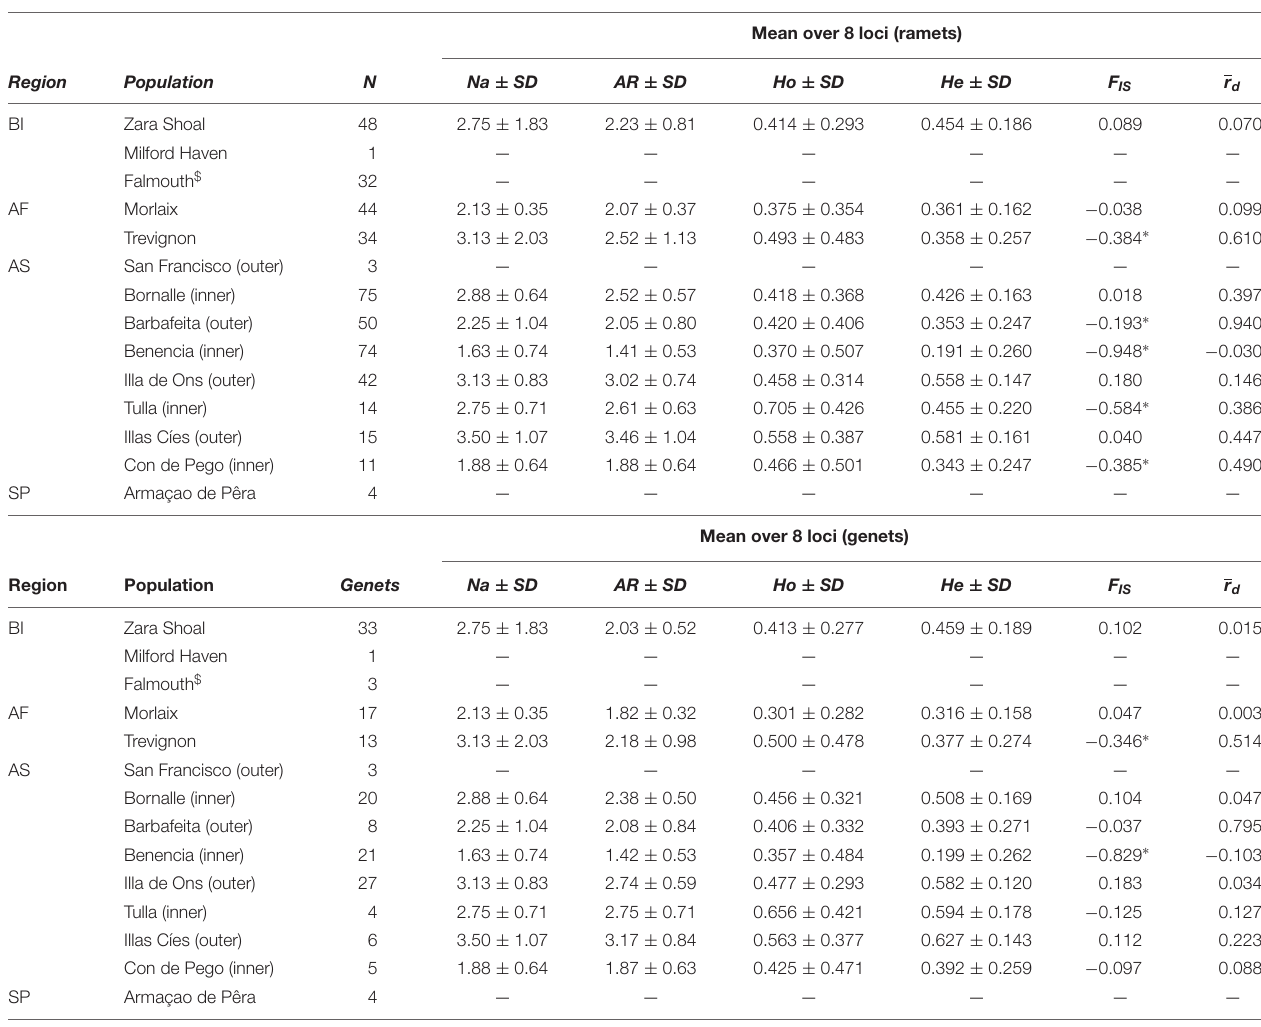
TABLE 2 | Genetic diversity estimates, inbreeding coefficient and linkage disequilibrium calculated for eight polymorphic microsatellite markers in ten sites where Phymatolithon calcareum were sampled along the Atlantic coasts of Europe.